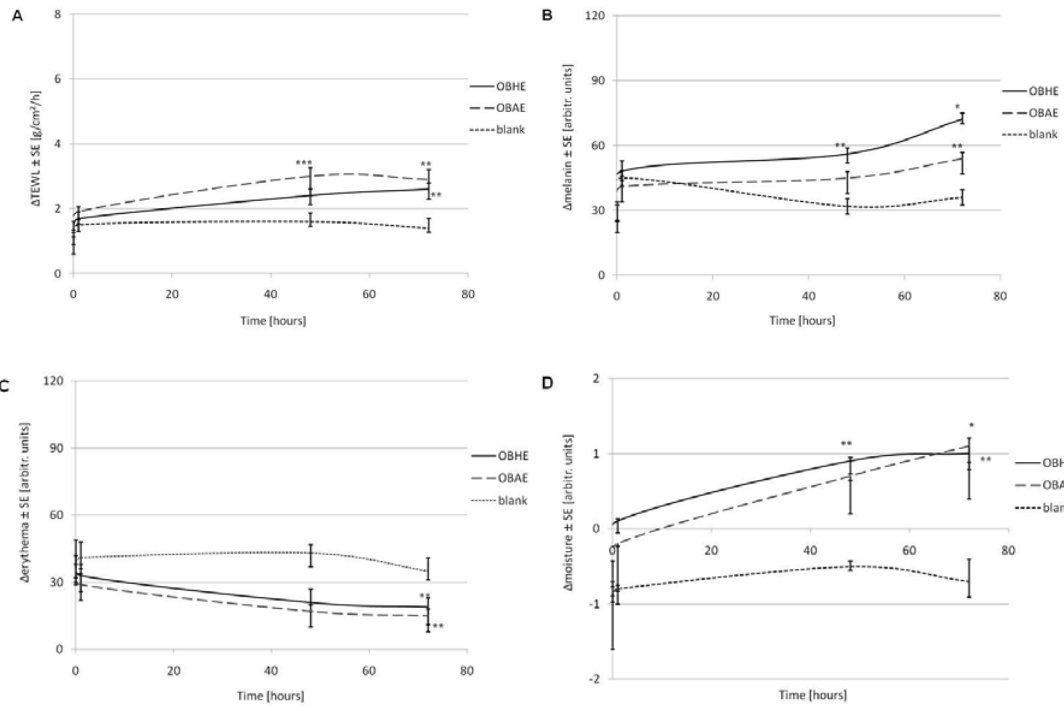
Figure 5. Changes of skin parameters in time: ( A )—transe(pidermal water loss, ( B )—melanin, ( C )—erythema, and ( D )—moisture of stratum corneum (* p < 0.05; ** p < 0.001; *** p < 0.001).